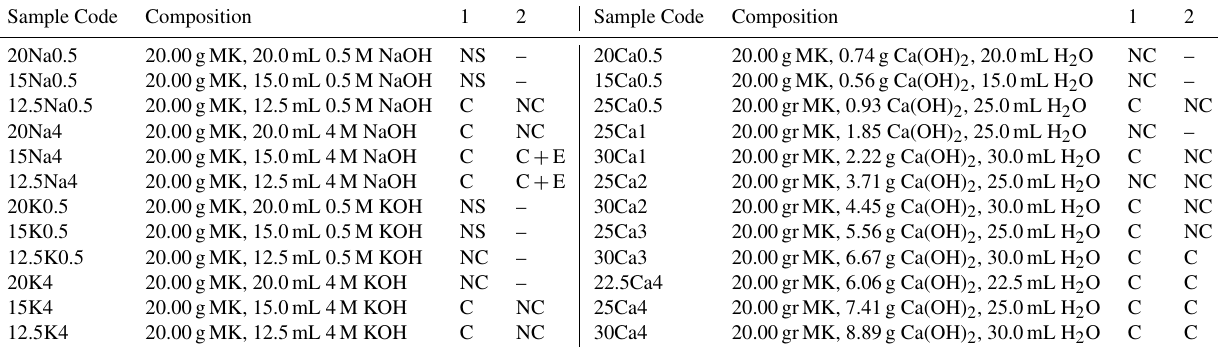
Table 1. Sample codes of Batch 1 with different activators and the results from the reactivity test 1 and 2 of Batch 1. NS: No/not enough setting, NC: Not fully cured, C: cured, E: Efflorescence. Sample Code